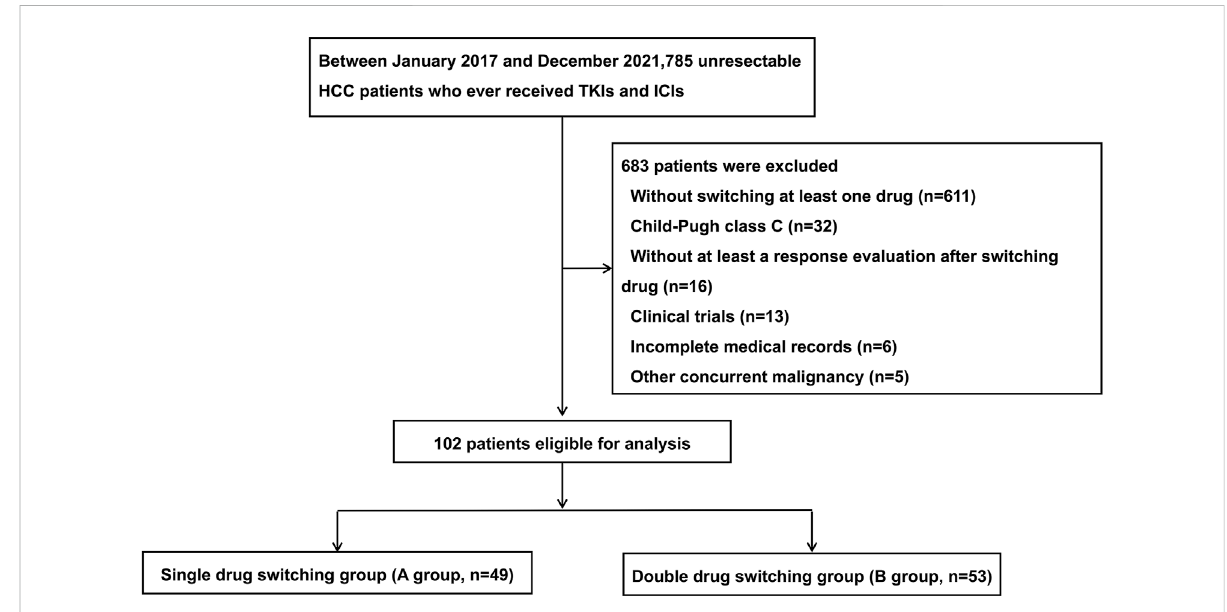
FIGURE 1 The fl ow chart of the disposition process of patients. HCC, hepatocellular carcinoma; TKIs, tyrosine kinase inhibitors (TKIs); ICIs, immune checkpoint